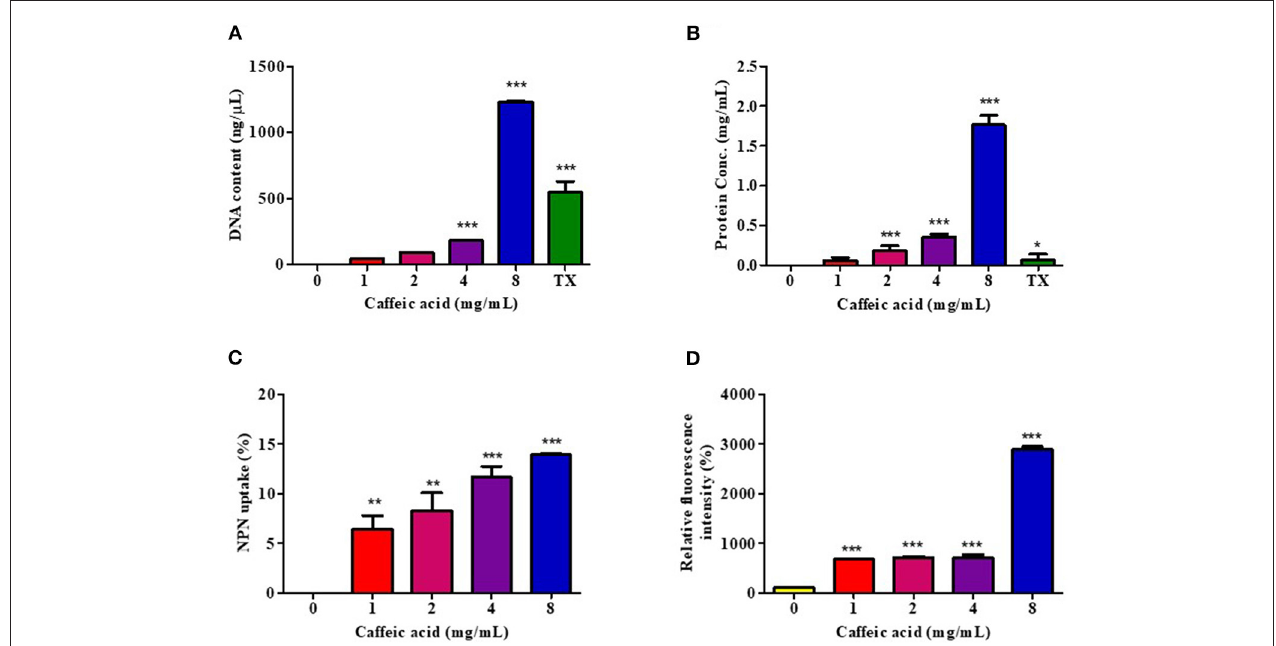
FIGURE 2 | Effect of CA on membrane permeability. V. cholerae O1 El Tor N16961 was treated with CA at a concentration of 1–8 mg/mL for 1h at 37 ◦ C. The intracellular leakage of nucleotides (A) and proteins (B) were measured, and 0.1% Triton X-100 (TX) was used as a positive control. The outer membrane disruption and membrane potential dissipation were investigated by the percentages of NPN uptake (C) and Rh123 relative fluorescence intensity (D) , respectively. Significant differences compared to untreated controls are indicated by asterisks (* p < 0.05, ** p < 0.01, and *** p <